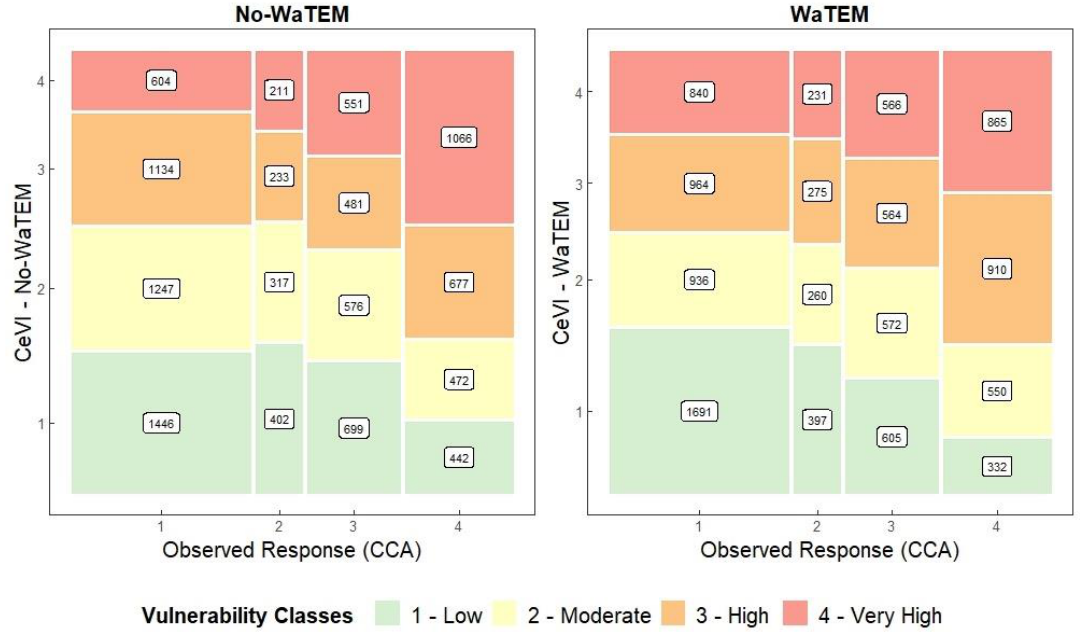
Figure 7. Mosaic plot of the CeVI (No-WaTEM and WaTEM models) and CCA (calculated by polygonal approach) classes. The colors green, yellow, orange, and red correspond, respectively, to the classes CeVI low (1), moderate (2), high (3) and very high (4). The size of each box is relative to the number of cases of coupling (reported also as